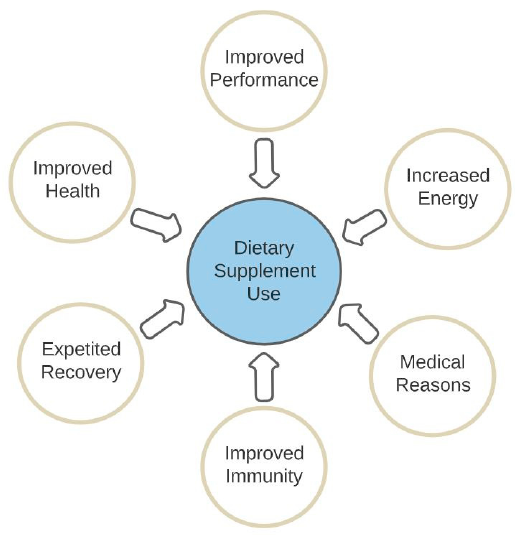
Figure 1. Athletes’ motivations for dietary supplement usage.